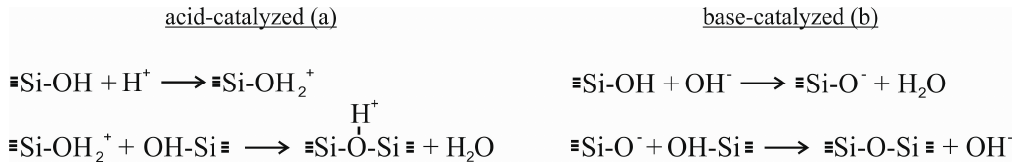
Figure 3. Scheme of pH-dependent catalytic partial reactions, acid-catalyzed ( a ) and base-catalyzed ( b ).